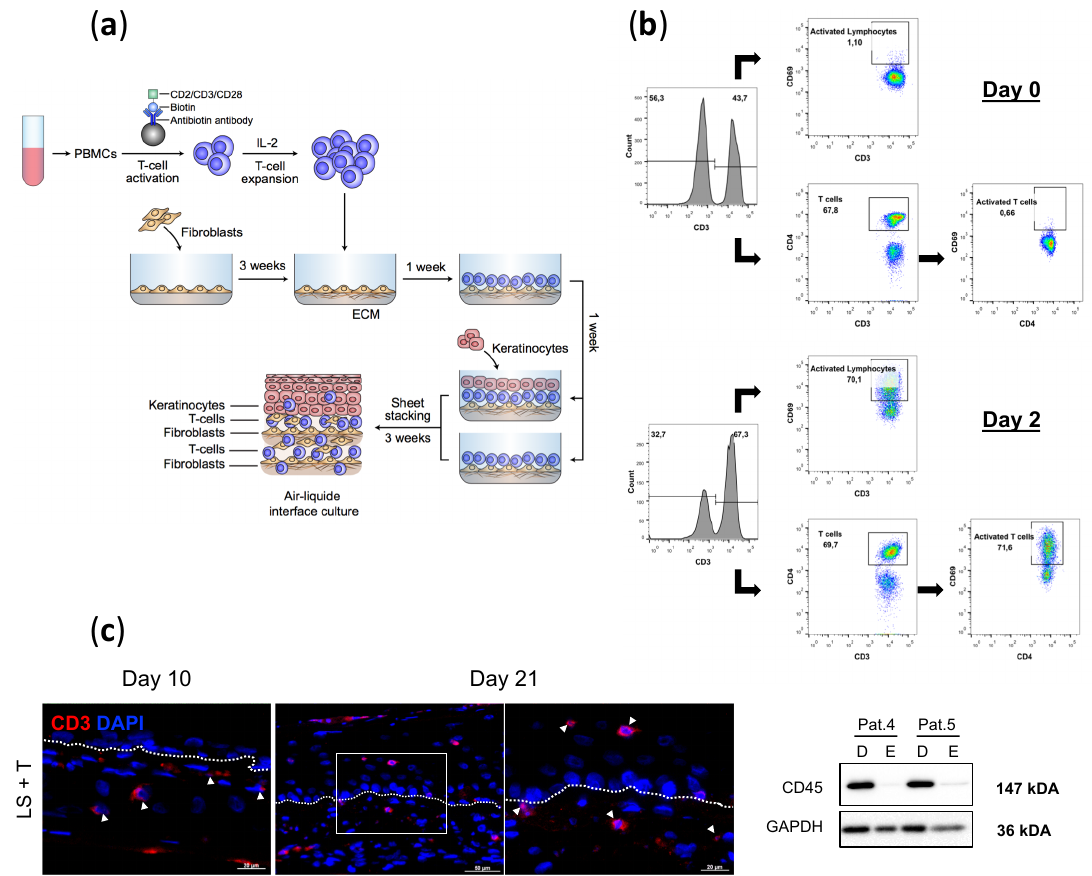
Figure 1. Generation of an immunocompetent skin model produced by tissue engineering. ( a ) Schematic experimental design for the generation of immunocompetent lesional (LS) tissue- engineered skin human model. ( b ) Flow cytometric quantification of CD4 + and CD69 + populations on day 0 and after 2 days of activation. Populations were analyzed for co-expression with CD3. Cells in the first panel were gated for viable cells. ( c ) Infiltration of T cells in LS (LS + T) was assessed by immunofluorescence staining for CD3 and DAPI at day 10 and 21 of the air-liquid culture. White arrows indicate positive CD3 cells. Dashed white lines represent the basement membrane. The third panel is a magnification of the delimited area of the second one. Scale bar (first and third panel) = 20 µ m. Scale bar (second panel) = 50 µ m. CD45 expression (relative to GAPDH) in the dermis (D) or epidermis (E) of LS reconstructed skin was evaluated by western blotting analysis. LS4 and LS5 refer to patients 4 and